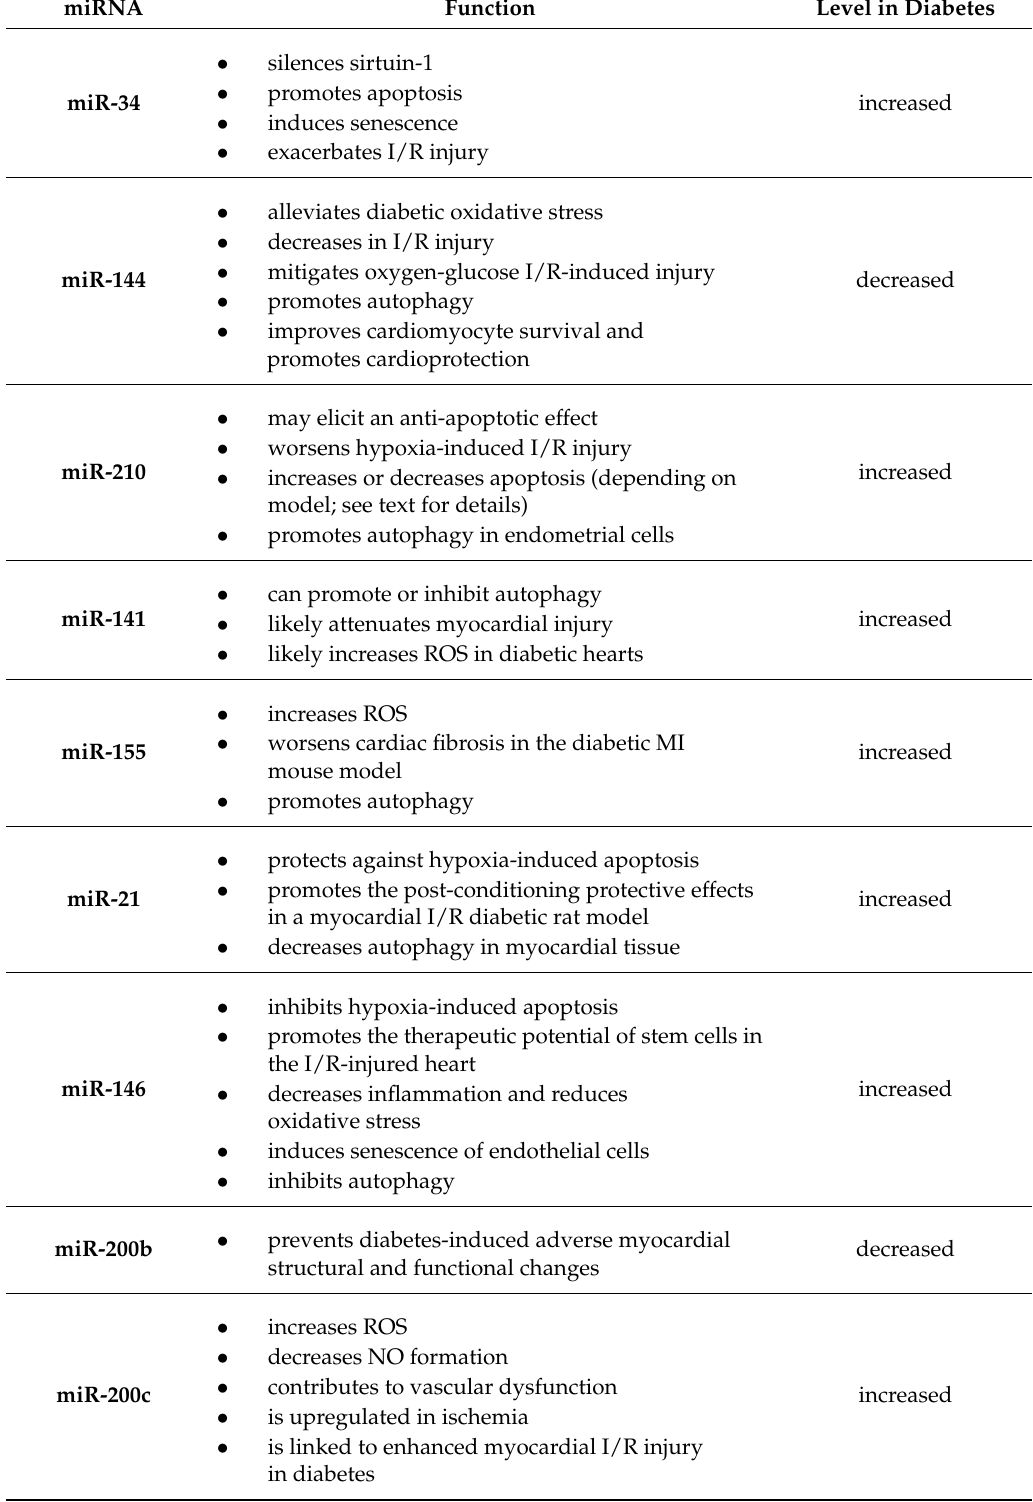
Table 1. A list of miRNAs implicated in diabetes that potentially modulate I/R injury via various mechanisms.